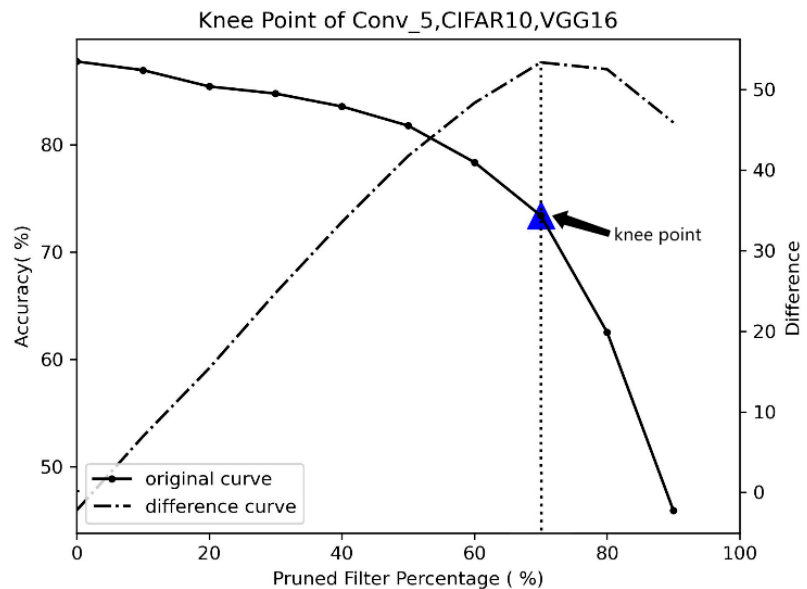
Figure 6. The process of determining the knee point is shown in this figure. First, calculate the difference curve according to the original curve. Then, the knee point can be found by calculating the maximum value of the difference curve, because of the same abscissa.